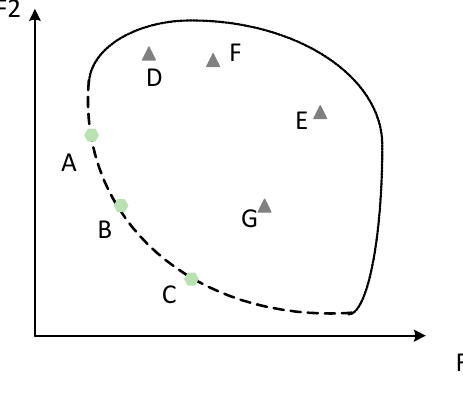
Figure 1. Pareto front (PF) of two goals.